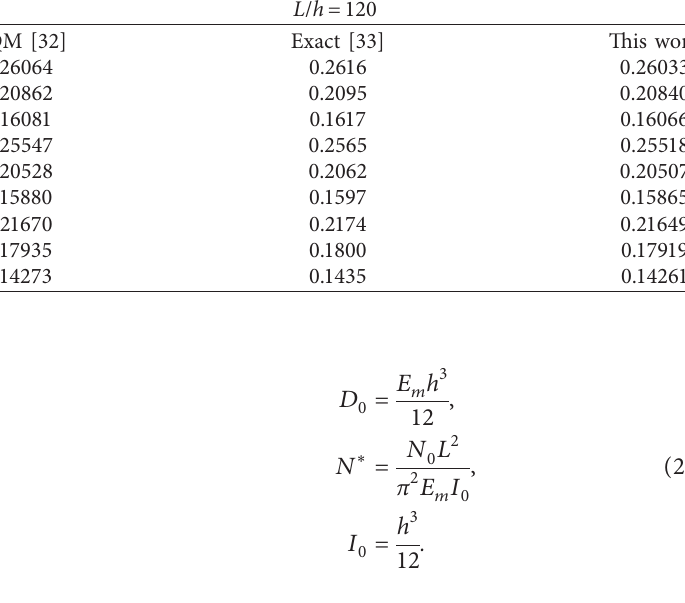
L 4 w of the FGM beam under uniformly distributed load resting 0 max